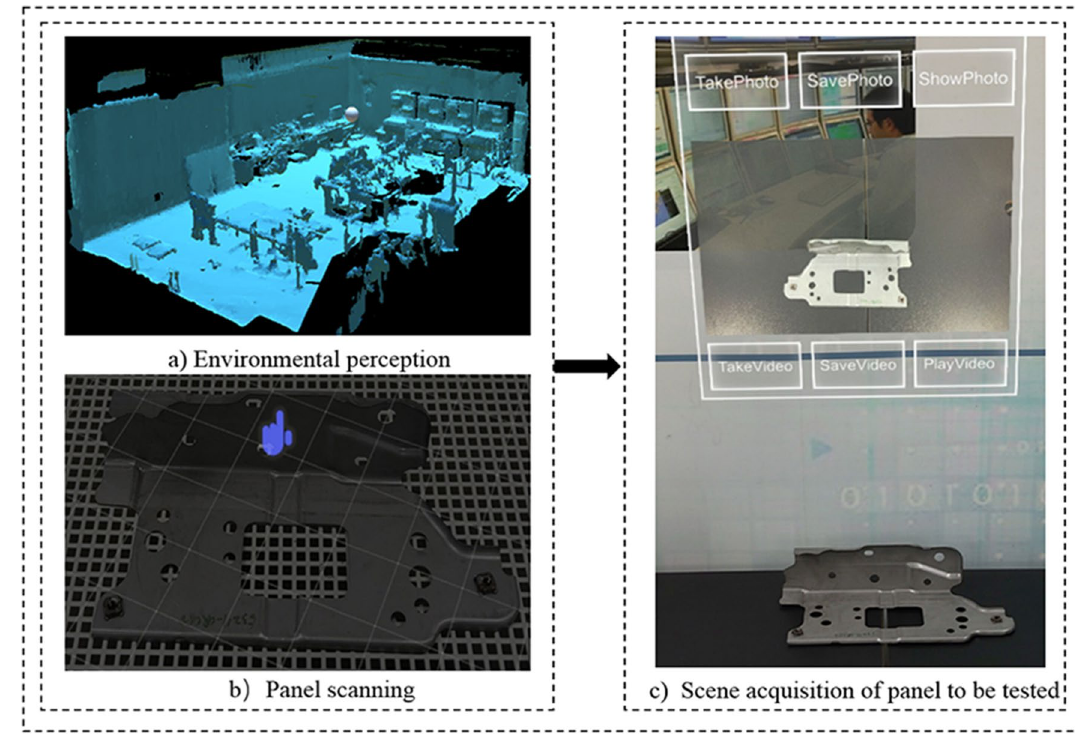
Figure 5. Environment perception and acquisition.